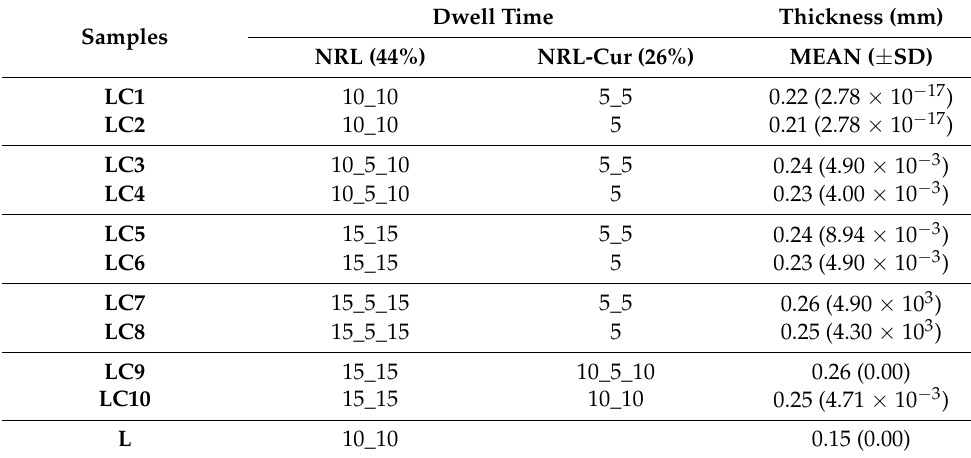
Table 1. Dwell time of LC film samples and their